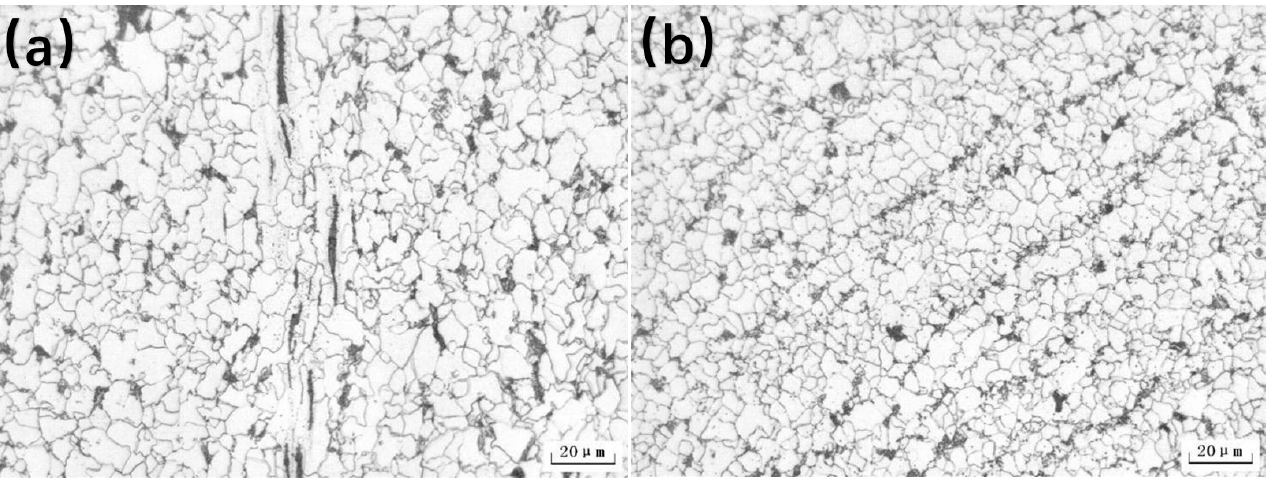
Figure 10. Microstructure of 2# pipe ( a ) welding zone; ( b ) heat-affected zone.